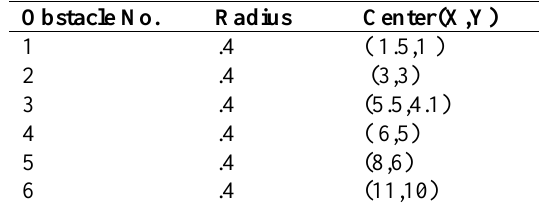
Obstacles definitions for case